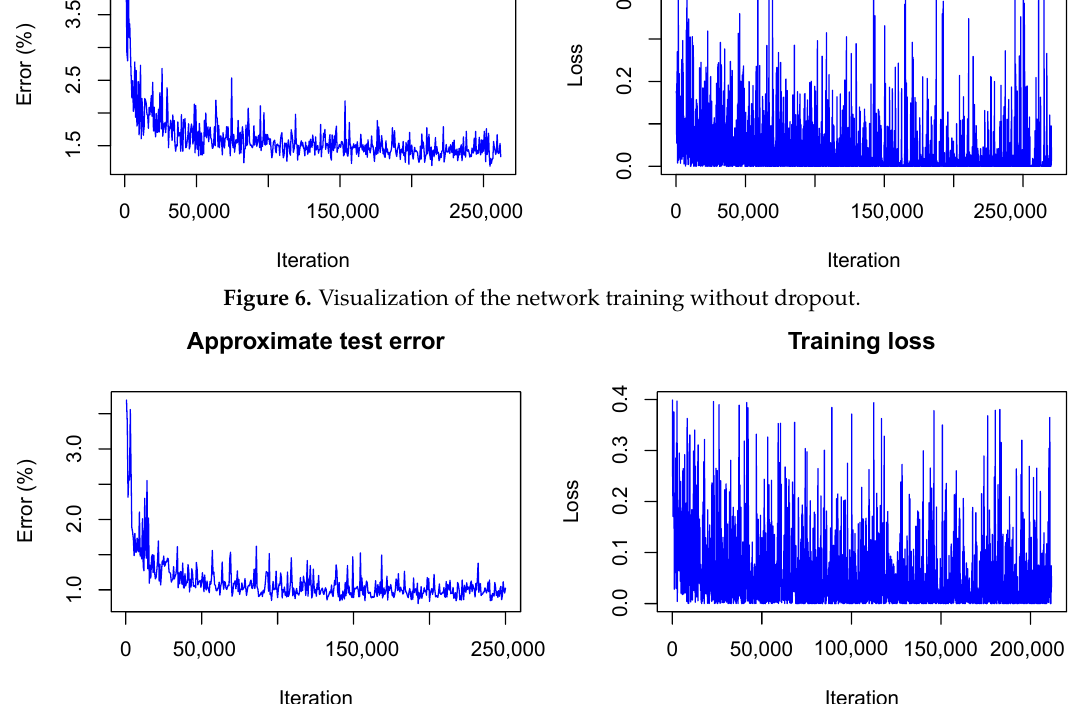
Figure 7. Visualization of the network training with